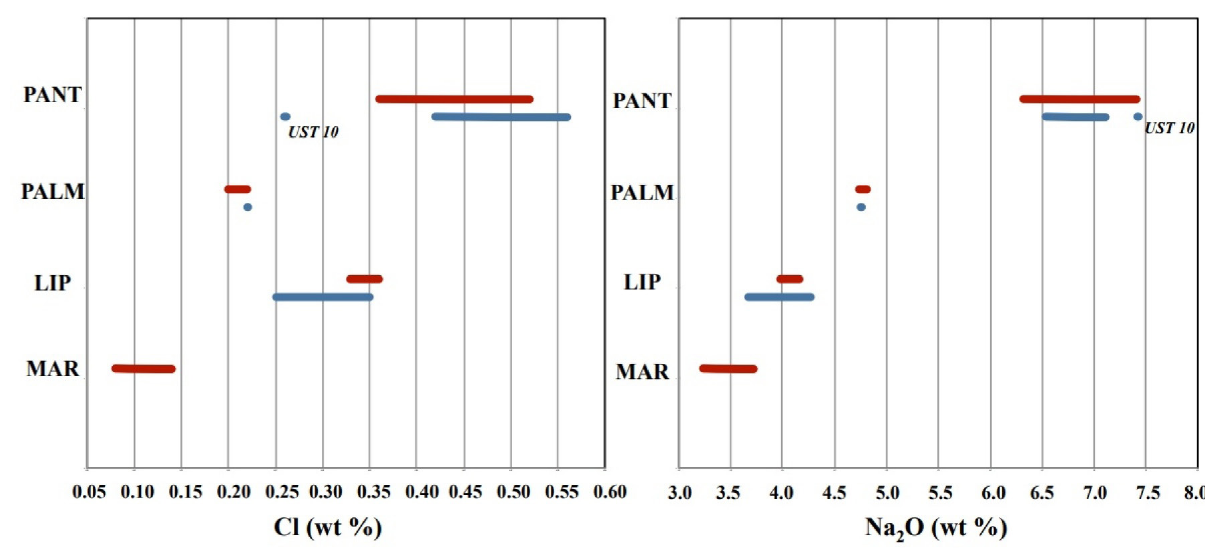
O contents in samples representative of four geological obsidian sources in the Central Mediterra- Figure 5: Variation ranges of Cl and Na 2 nean (red) and in the 174 archaeological samples (blue) of known provenance collected at Ustica (Foresta Martin et al., 2017). Abbreviations: MAR = Monte Arci; PALM = Palmarola; LIP = Lipari; PANT = Pantelleria. UST 10 is an archeological peralkaline trachytic obsidian from Pantel- leria source. Red bars = geological samples, blue bars = archeological